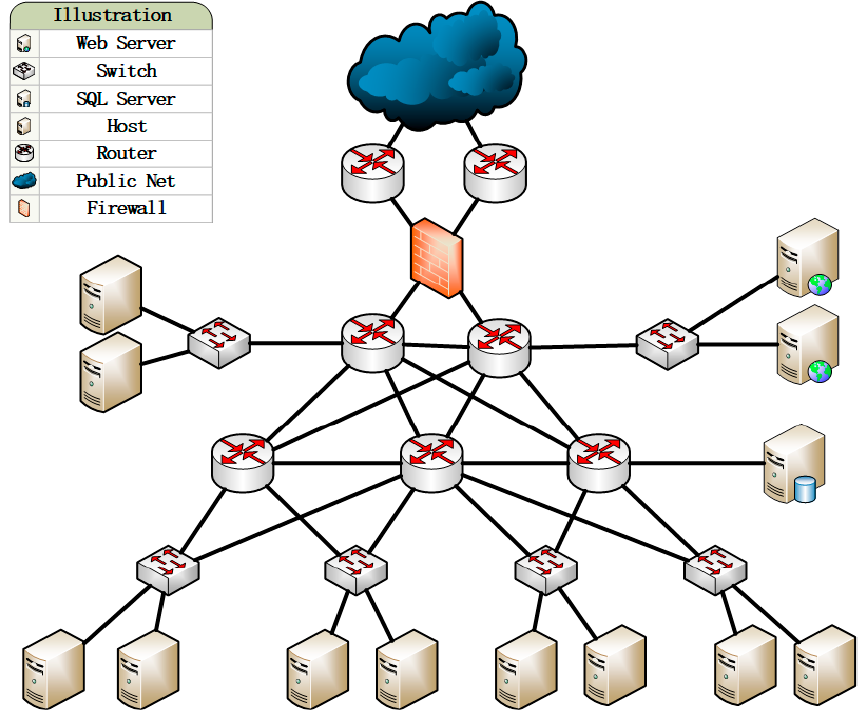
Figure 4. Network structure.